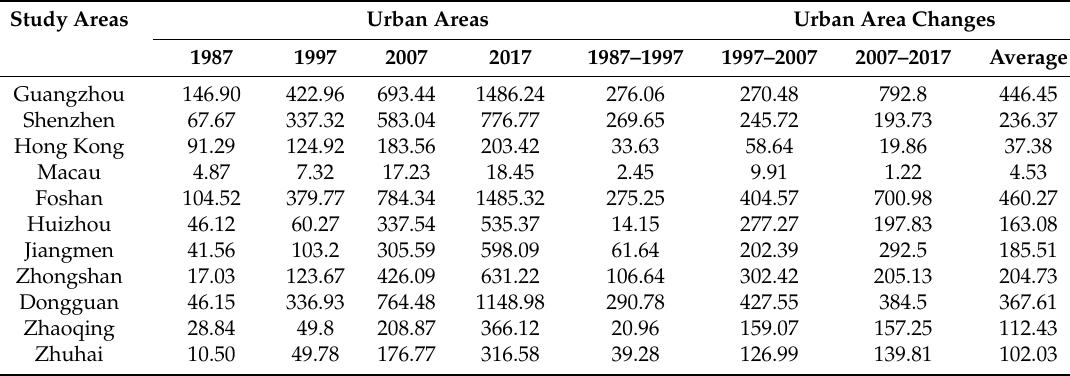
Table 6. Annual increase (AI), expansion rate (ER, %), and annual growth rate (AGR, %) for 11 cities in the GBA for three neighboring periods in 1987–2017.